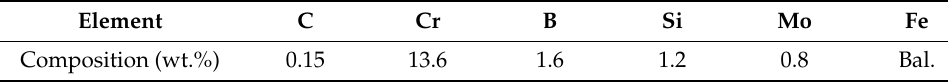
Table 2. Chemical composition of Fe901 iron-based alloy powder.